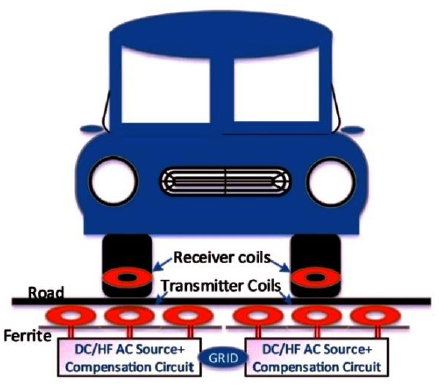
Figure 6. In-wheel wireless charging.